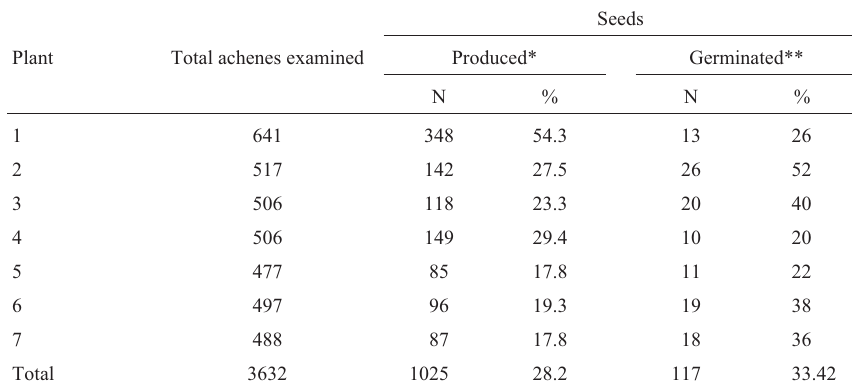
Table 1 - Seed production and germination capacity of Eupatorium laevigatum